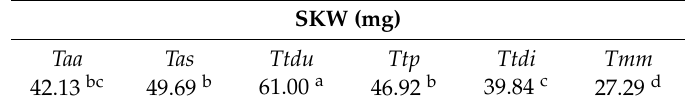
Table 2. Average single kernel weight (SKW) of the investigated wheat